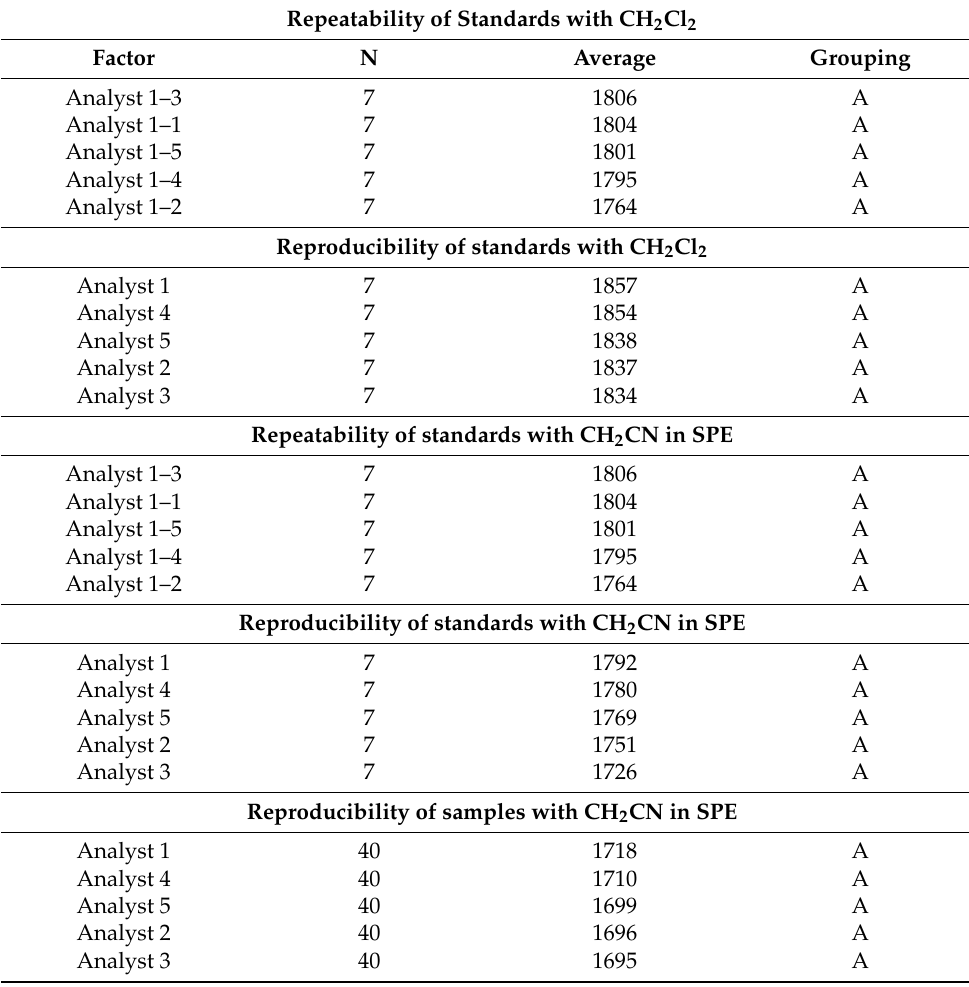
Table 3. ANOVA analysis for standards and samples using the Tukey method with 95%